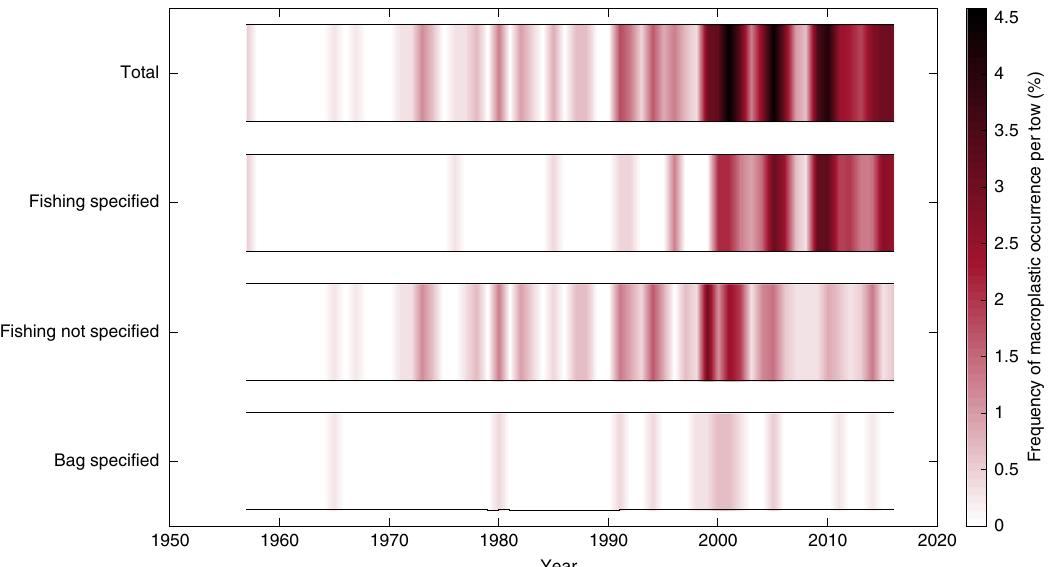
Fig. 3 Annual macroplastic counts in categories from 1957 to 2016. Timeseries plot for four categories (total, fi shing speci fi ed, fi shing not speci fi ed, bag speci fi ed) of macroplastic entanglements from 1957 to 2016, with all macroplastics observed included in the total category. The annual counts of macroplastics observed have been normalised to a percentage frequency of occurrence per Continuous Plankton Recorder tow (%)